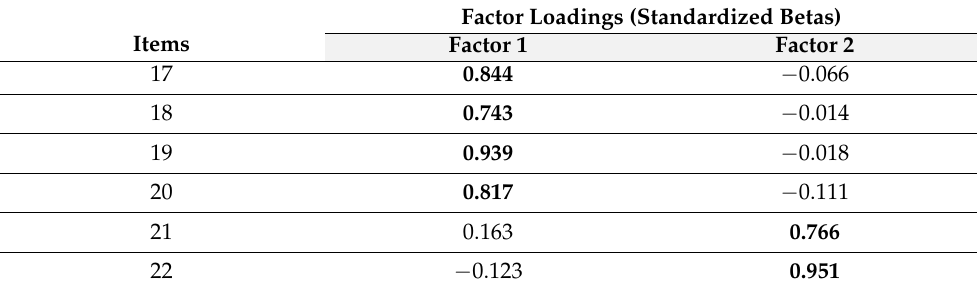
Table 6. The exploratory factor analysis of the self-care confidence.